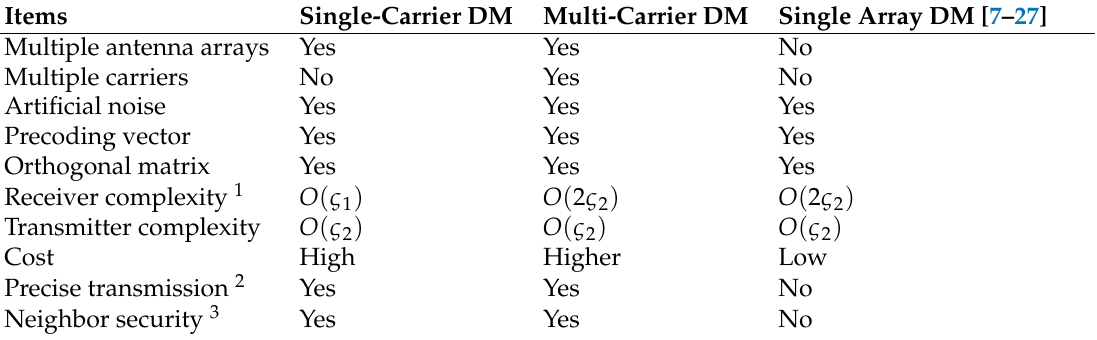
Table 1. Comparisons for multiple antenna arrays DM and single antenna array DM